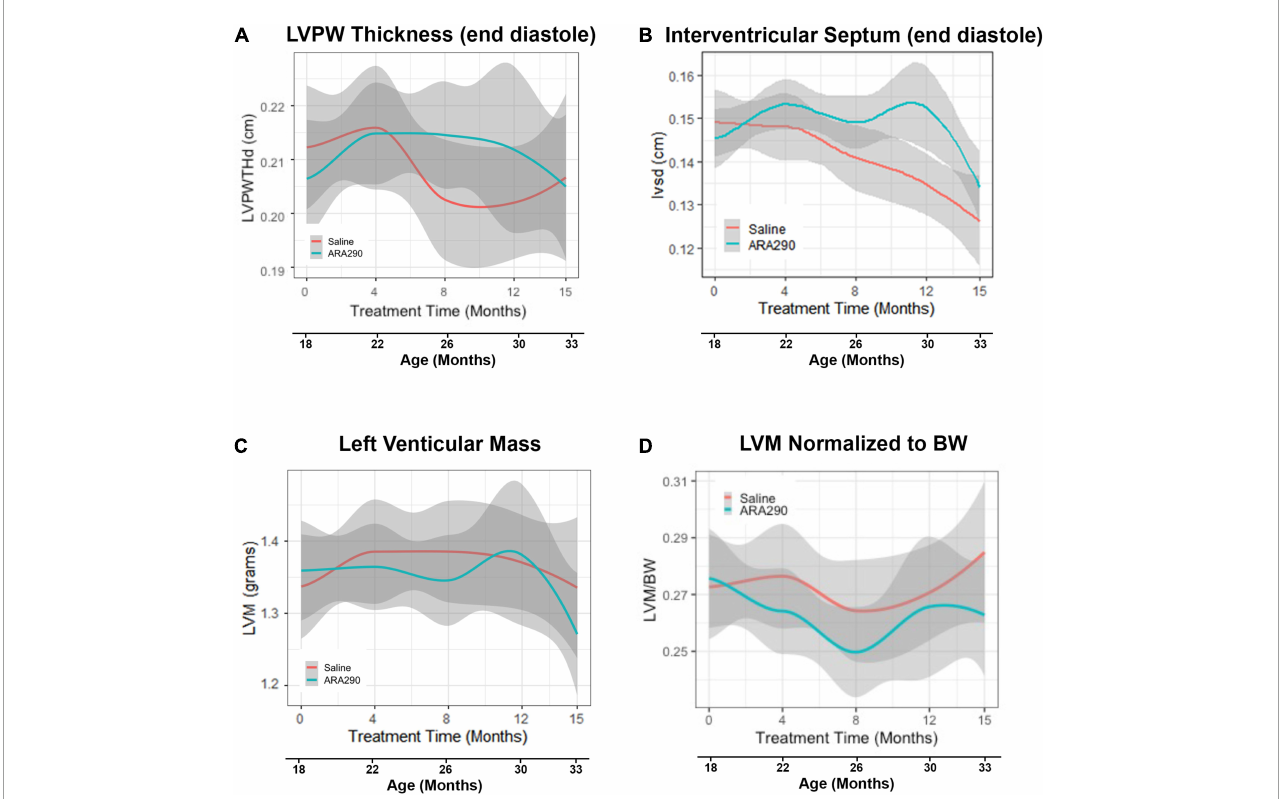
FIGURE2 Loess smooth curve (Red = Saline, Blue = ARA290) with 95% confidence intervals (gray) depicting the age-associated changes in left ventricular posterior wall thickness at end diastole (A) , interventricular septum posterior wall thickness at end diastole (B) , left ventricular mass (C) , and left ventricular mass normalized to rat body weight (D) . Statistically significant interactions between treatment groups are shown.